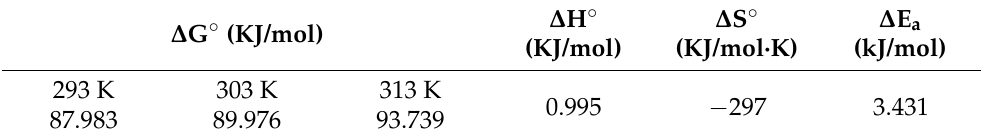
Table 5. Thermodynamic parameters for adsorption of BR5 on